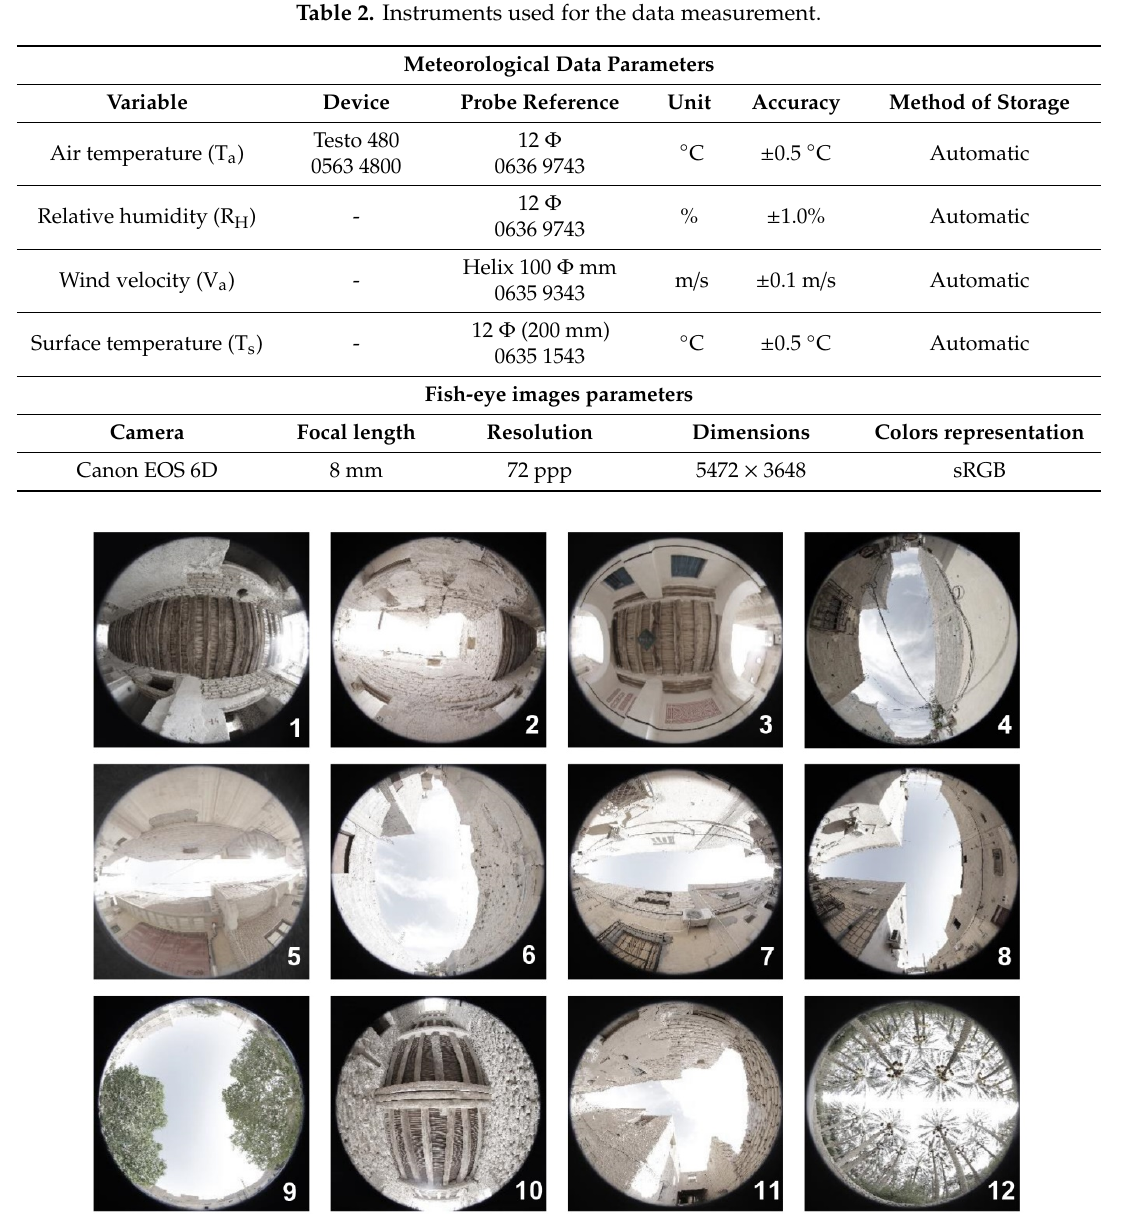
Figure 3. Fish ‐ eye images of 12 studied points: (1, 2, 3) Old Lichana; (4, 5, 6) Old Tolga; (7, 8, 9) New Tolga Downtown; (10, 11) Old Farfar; (12) Palm Grove.